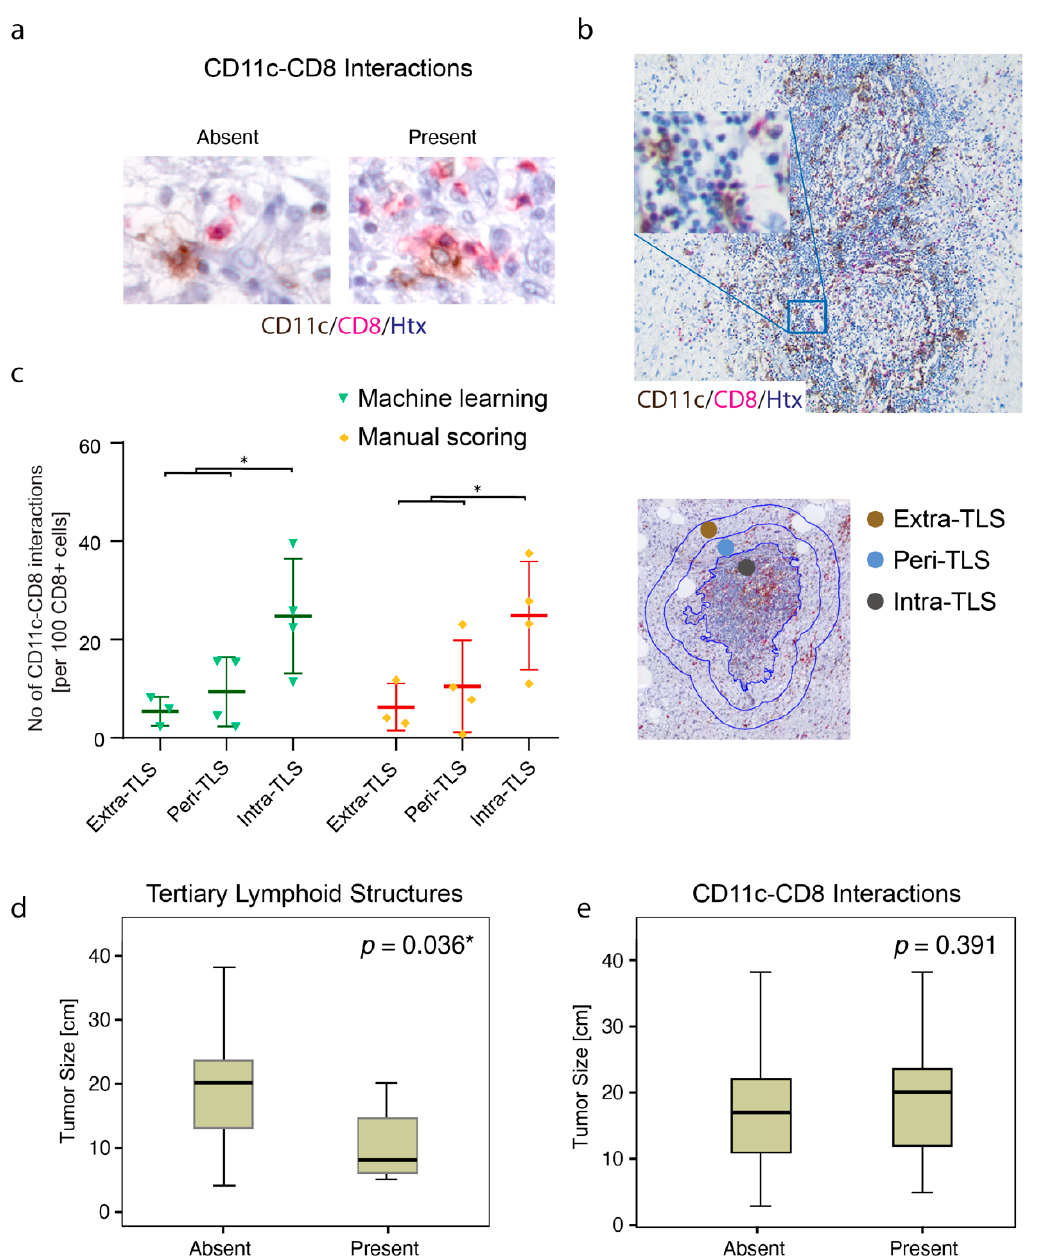
Figure 2. Tertiary lymphoid structures (TLSs) are found in smaller tumors and display high density of CD11c+ cells and CD8+ cells. ( a ) Microphotographs with double IHC visualizing absence or presence of intratumoral cell–cell interactions between CD11c+ and CD8+ cells in liposarcoma; ( b ) Microphotograph with a mature intratumoral TLS displaying high density of CD11c+ cells and CD8+ cells; ( c ) Quantification of CD11c–CD8 interactions/100 CD8+ cells outside (extra-TLS and peri-TLS) or inside (intra-TLS) tumor-associated tertiary lymphoid structures (TA-TLS) formations (+/ − SD). Each dot in the graph represents either manual scoring or the QuPath image quantification result originating from one out of four cases. Statistical comparisons were performed with One-way Anova comparing intra-TLS regions with regions outside the TLS (close and distant). * p < 0.05; p < 0.05 is considered significant; ( d ) Box-plot visualization of presence of TLSs in relation to tumor size (Mann–Whitney U test); ( e ) Box-plot visualization of presence of CD11c–CD8 interactions in relation to tumor size (Mann–Whitney U test). * p < 0.05; p < 0.05 is considered significant.